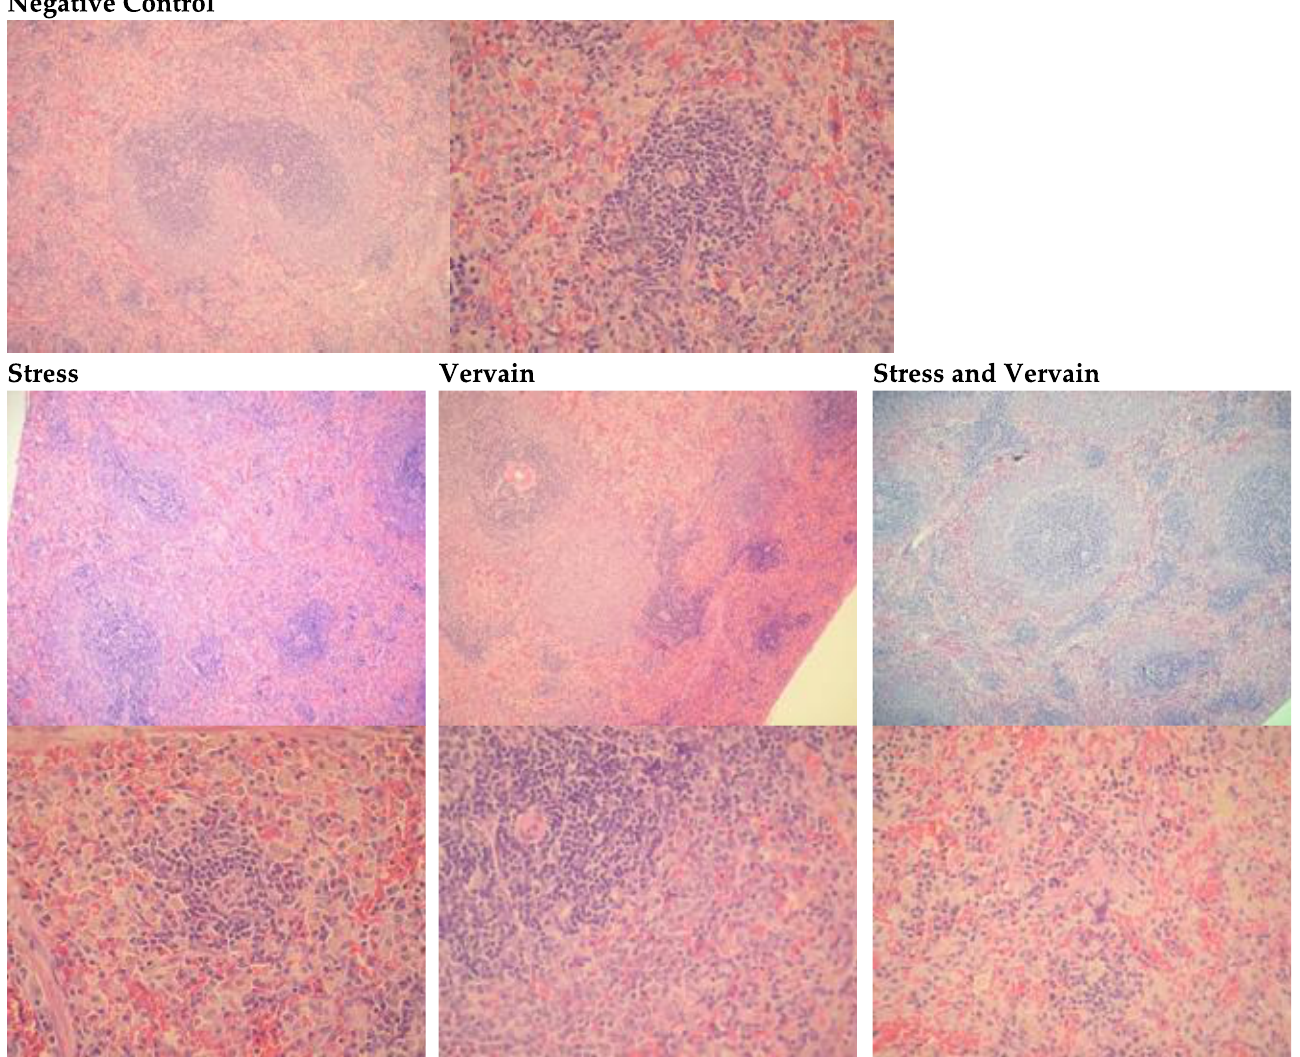
Figure 10. Analysis of histopathologic changes in the spleen, H.E. staining. Two ampliations are depicted: 100 × ( top ) and 400 × ( bottom ). The first images are representative of the negative controls. No significative changes were observed in the treatment groups; however, giant cells and some iron enrichments (more “brownish” staining) were registered in the animals submitted to acute stress. Splenic organization in the animals submitted to stress factors was affected. These morphological changes were absent in the animals orally administered vervain.